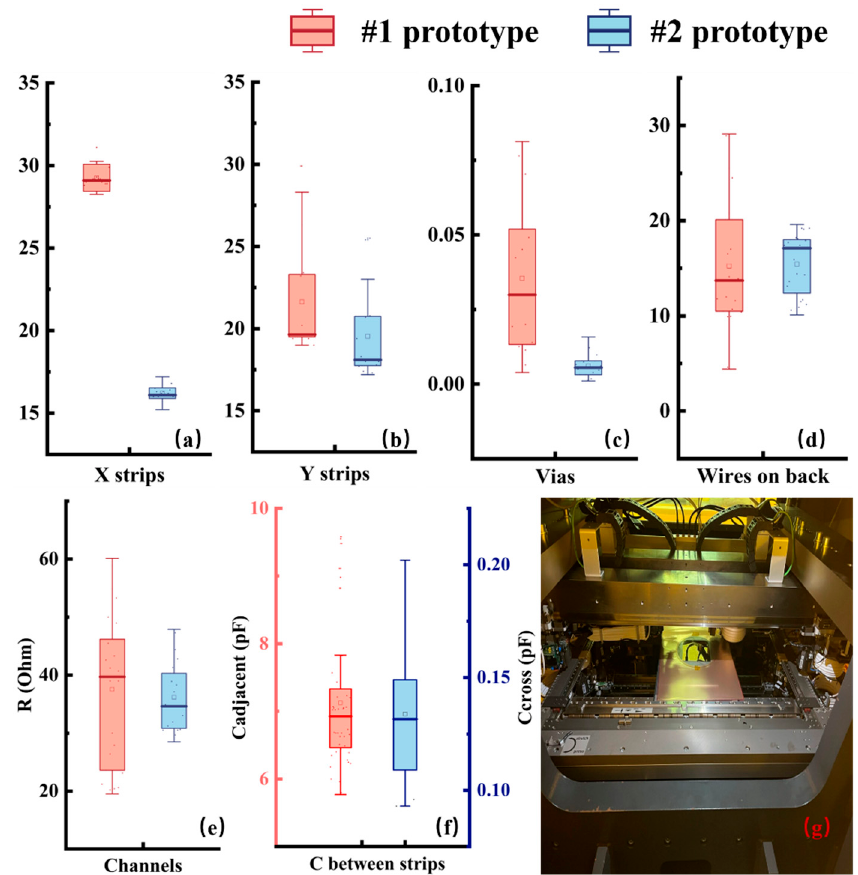
Figure 11. Electrical properties of charge detectors. ( a , b ) are the resistance of strips from one end to the other of the detector structure on the front side. ( c ) is the resistance of TGV with conformal copper. ( d ) is the resistance value of the back-side wires. ( e ) is the total resistance of each channel. ( f ) is the capacity of adjacent strips shown in pink and the capacity of pads on two cross strips shown in blue. ( g ) is a photograph taken during the electrical test.